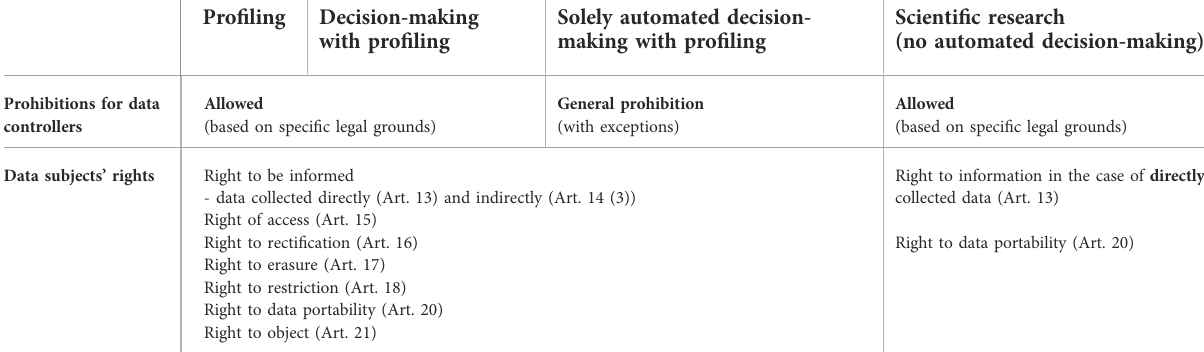
TABLE 2 The impact of pro fi ling, automated decision-making and scienti fi c research on the data subjects ’ rights in the General Data Protection Regulation (Meszaros, 2022). Pro fi